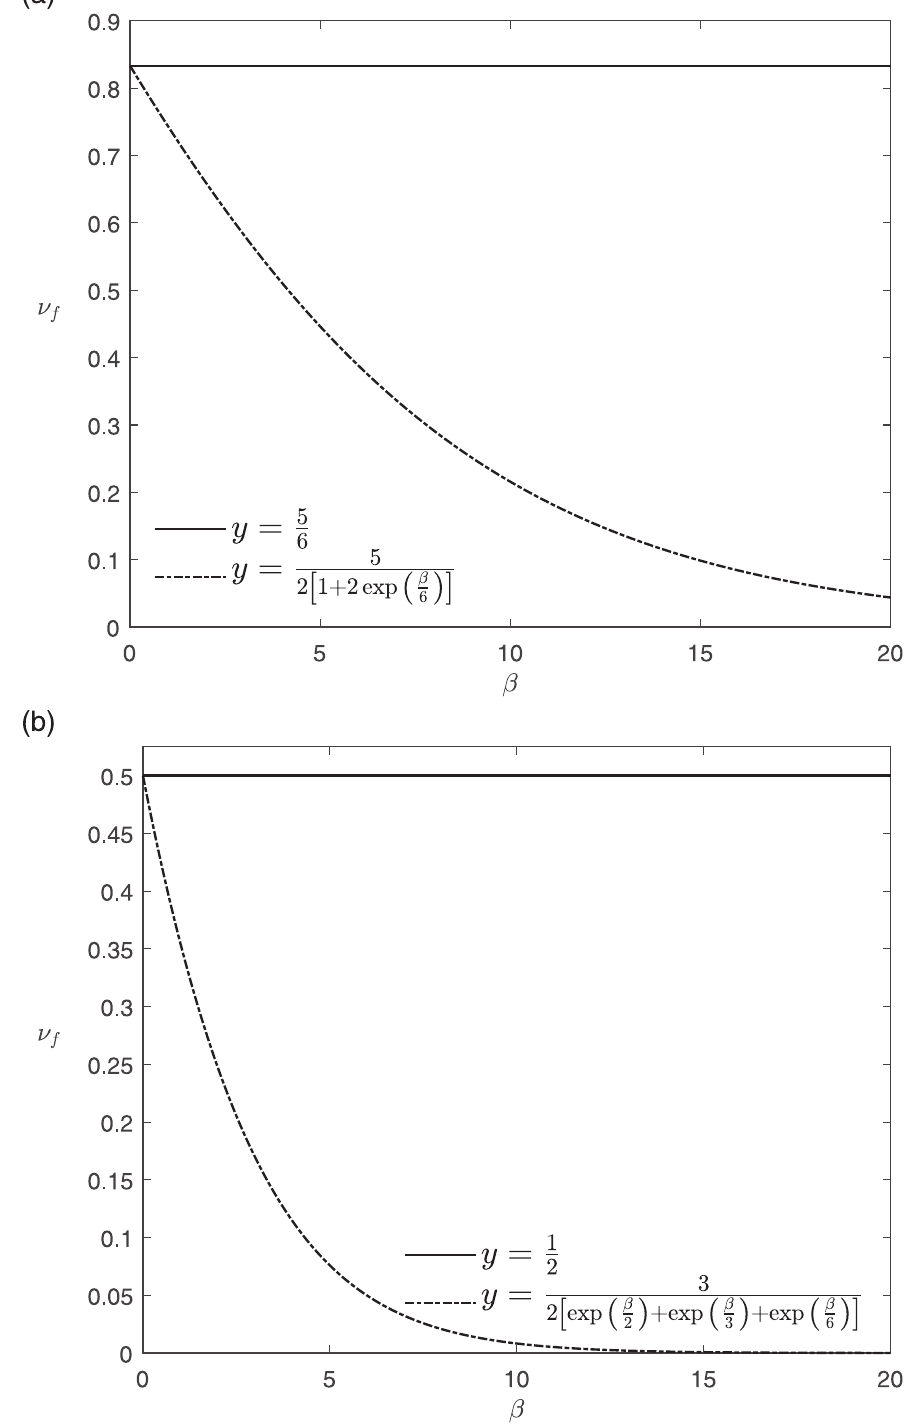
Fig 3. Similarly to Fig 2, the upper panel shows the aggregated appraisals of Newson et al. (2000) [72], Amberbir et al. (2011) [76] and Beasley et al. (2011) [77] according to De Pretis et al. (2019) [78] (solid line) and EA 3 (dash- dot line). The lower panel depicts the aggregated appraisals for Lesko and Mitchell (1999) [71] and Lesko et al. (2002) [73].